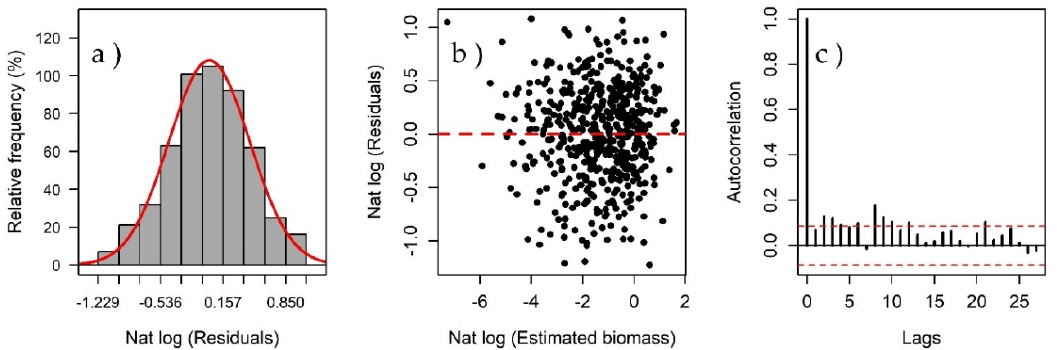
Figure 4. Histogram of residuals ( a ), estimated values against residuals ( b ) and correlogram of residuals of Equation (4) ( c ) of Agave lechuguilla Torr. in M é xico.